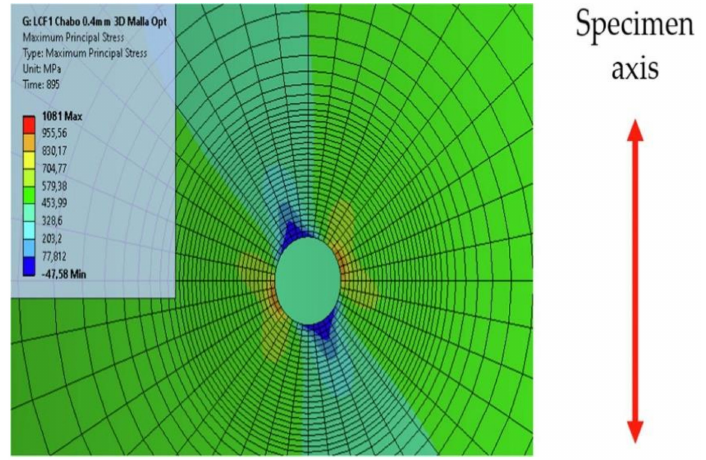
Figure 20. The distribution of maximum principal stresses around the 0.4 mm notch for the loading case B2. Reprinted with permission from ref. [71]. 2022,